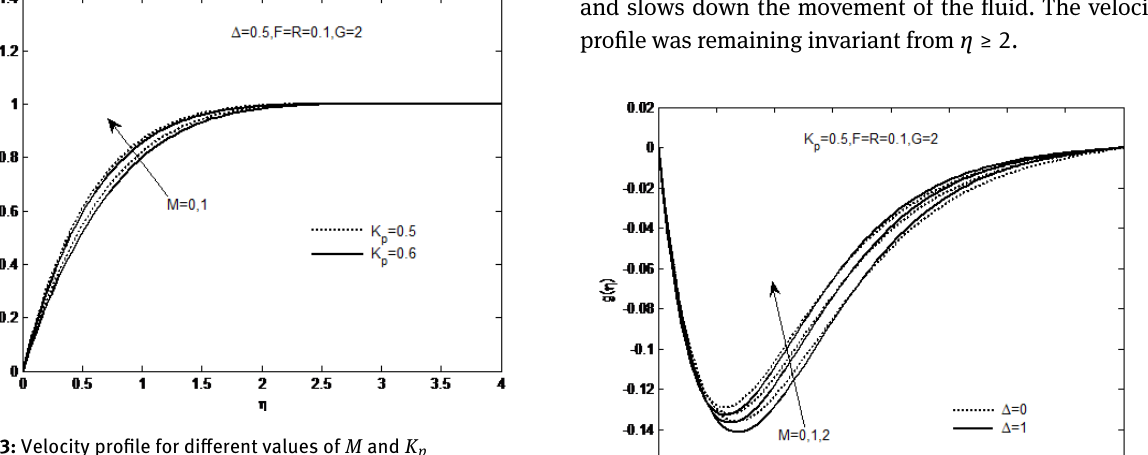
Fig. 3: Velocity profile for different values of M and K p